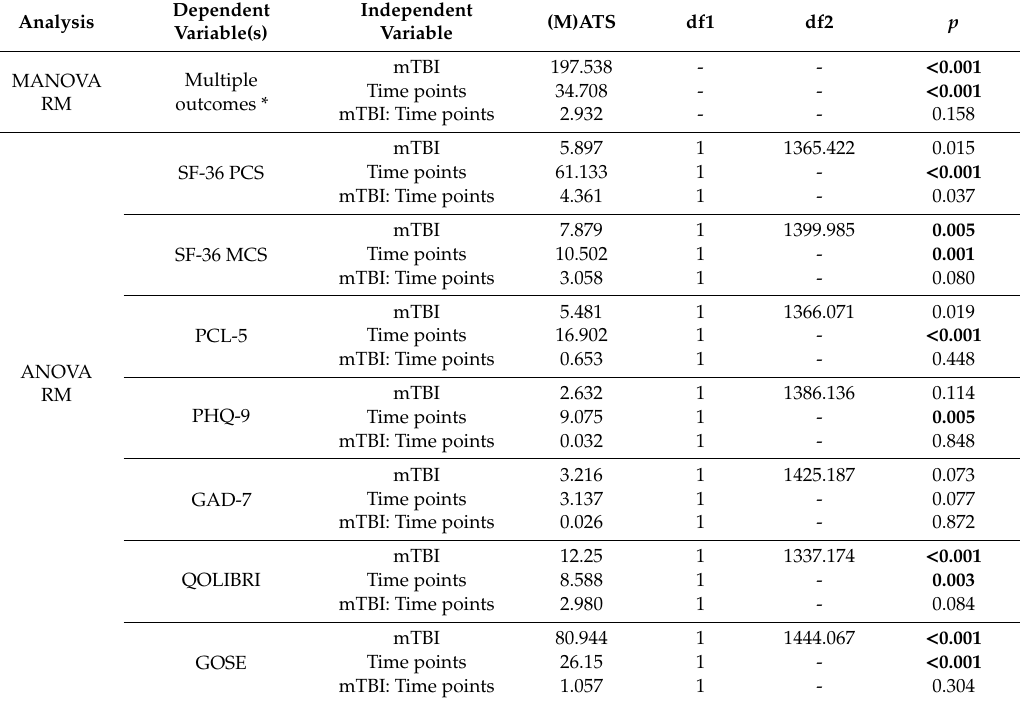
Table 3. Results of repeated measures MANOVA and repeated measures ANOVA. Analysis